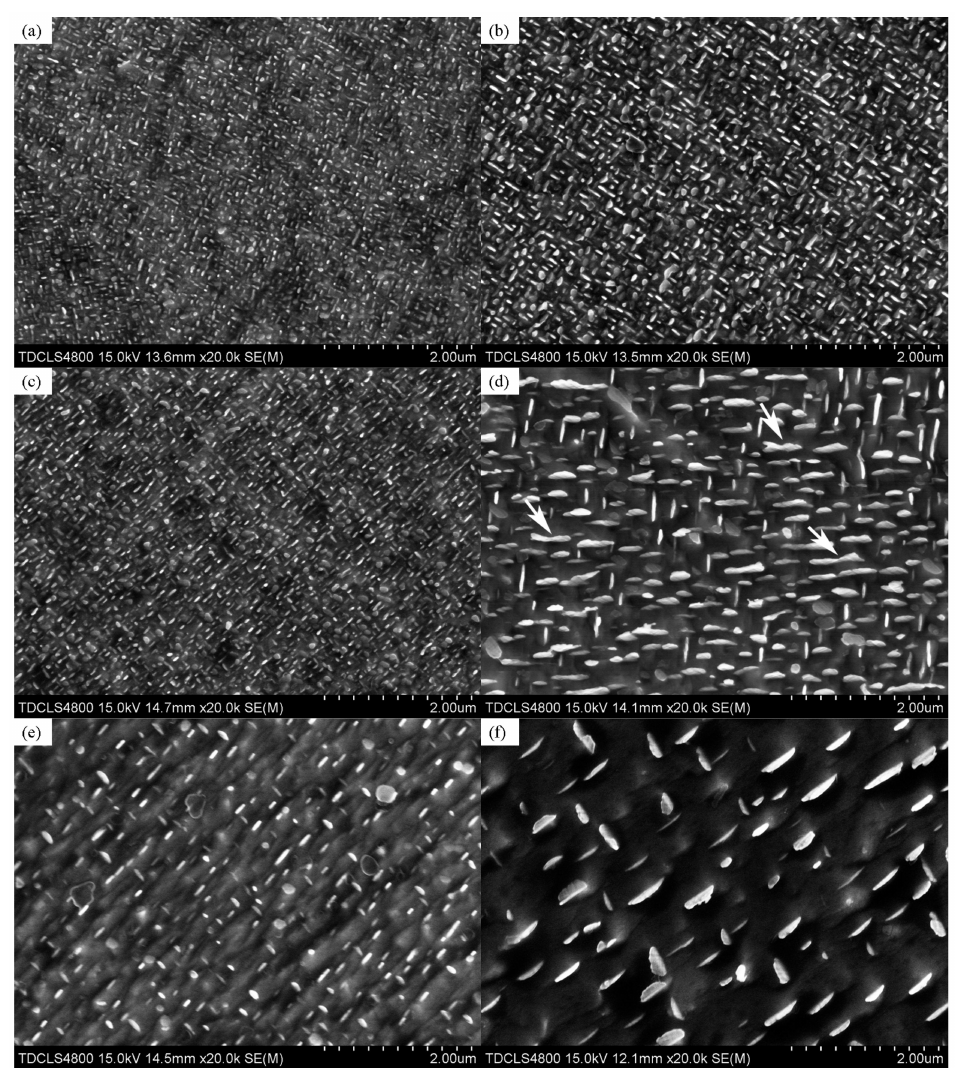
Figure 6. SEM images of the explored GH4169 alloy after isothermal aging at ( a ) 800 ◦ C for 2 h; ( b ) 800 ◦ C for 11 h; ( c ) 850 ◦ C for 2 h; ( d ) 850 ◦ C for 11 h; ( e ) 900 ◦ C for 2 h; and ( f ) 900 ◦ C for 11